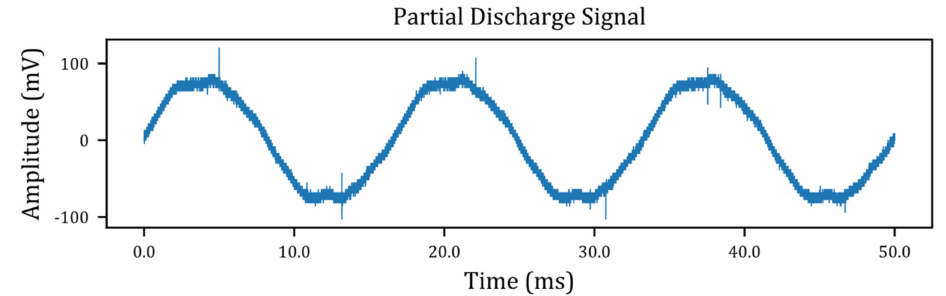
Figure 6. Example of a signal showing few pulses of partial